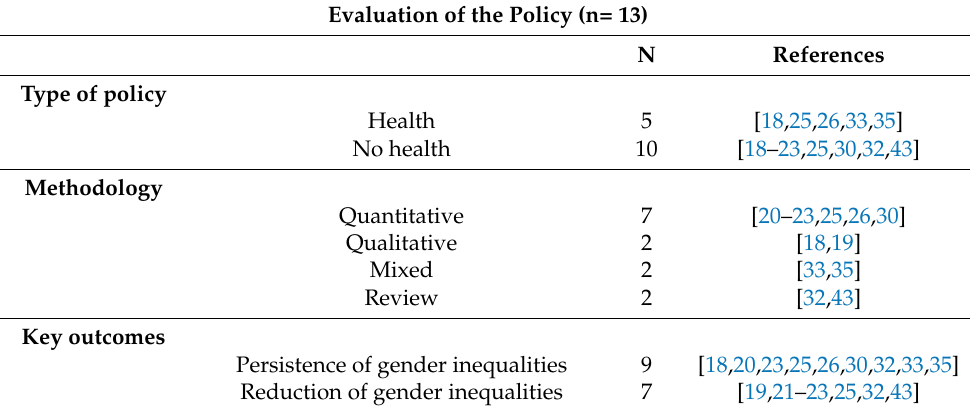
Table 3. Description of main characteristics and key outcomes of the 13 included papers evaluating policies aimed at reduce gender inequalities in